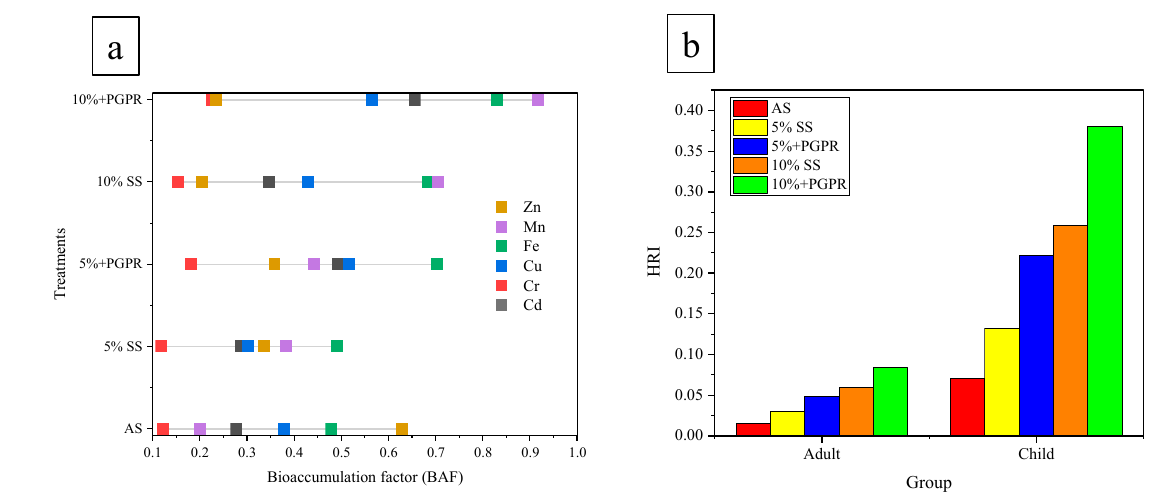
Figure 6. Effect of sewage sludge (SS) and plant growth-promoting rhizobia (PGPR) amendment on ( a ) metal element’s bioaccumulation factor (BAF) and ( b ) health risk index (HRI) in Ridge gourd ( L. acutangula ) fruits.